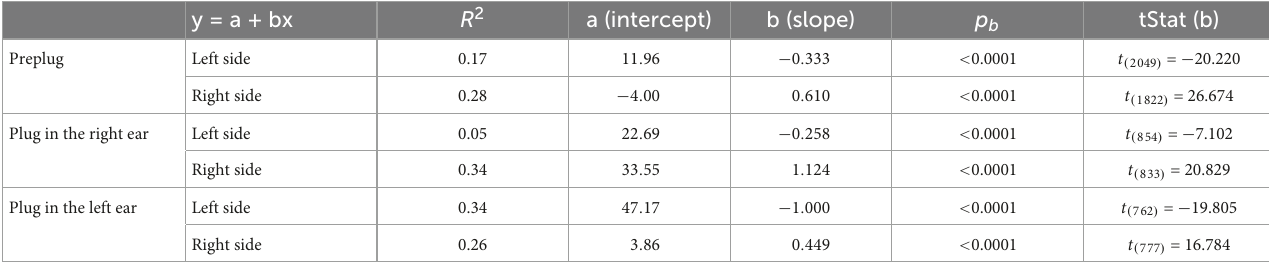
TABLE 1 Parameters of the fitted regression lines for head bearing errors in Figure 3